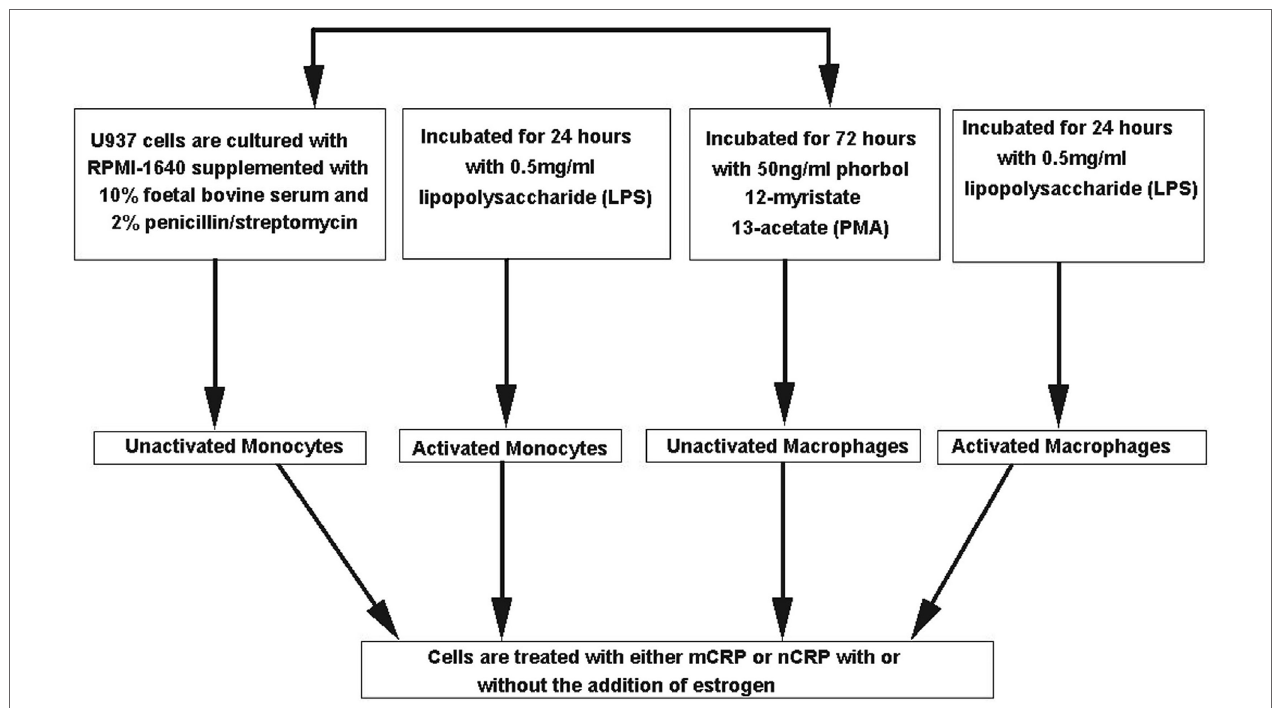
FigUre 1 | Flow chart of different treatment paths used to activate and differentiate the U937 cells. U937 cells were differentiated into a macrophage-like phenotype using 50 ng/ml phorbol 12-myristate 13-acetate (PMA) for 72 h and/or pre-activated for 24 h with 0.5 mg/ml lipopolysaccharide